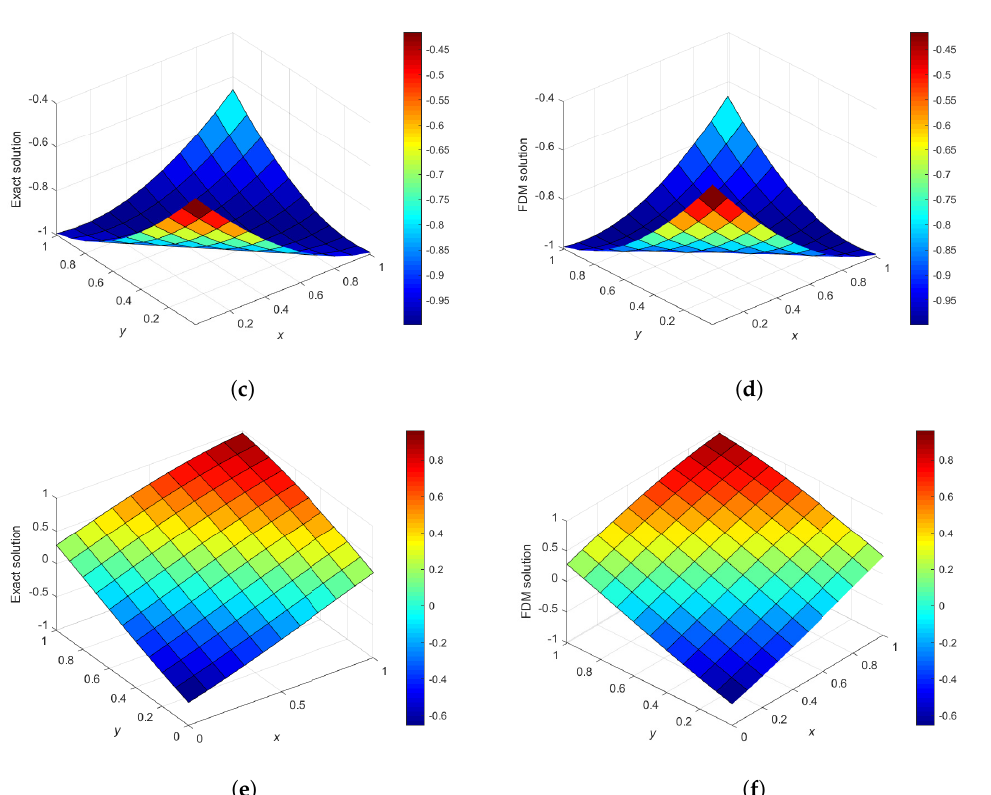
Figure 16. Plotsofexactandnumericalsolutionvs. x vs. y , usingtheclassicalFDMschemeofEquation(42) on Ω = ( 0,1 ) 2 at t = 0.10, 1.0, 2.0 used spatial step sizes ∆ x = ∆ y = 0.1 and time-step ∆ t = 0.0001.